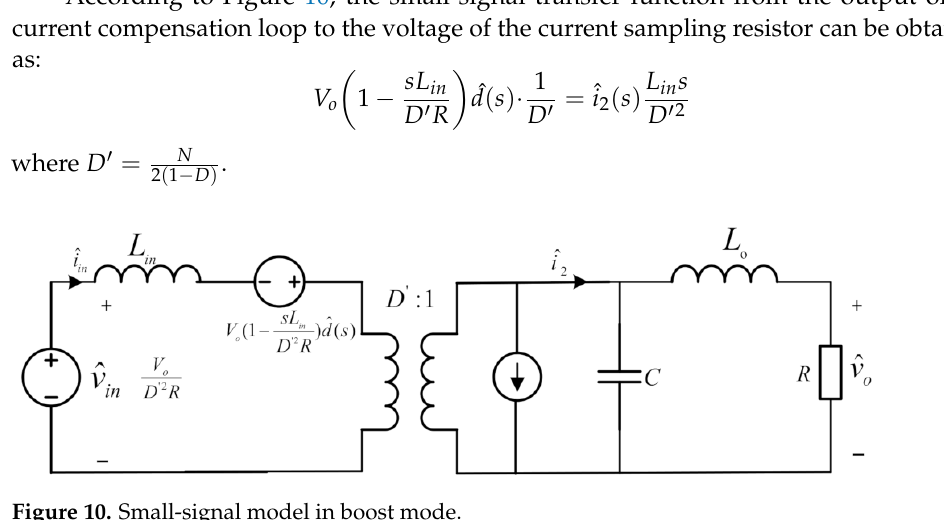
Figure 10. Small-signal model in boost